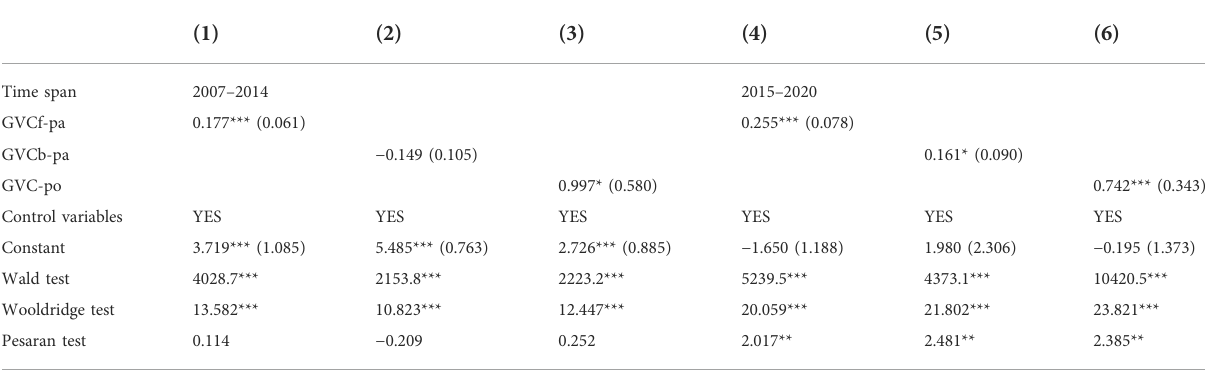
TABLE 6 Heterogeneity analysis